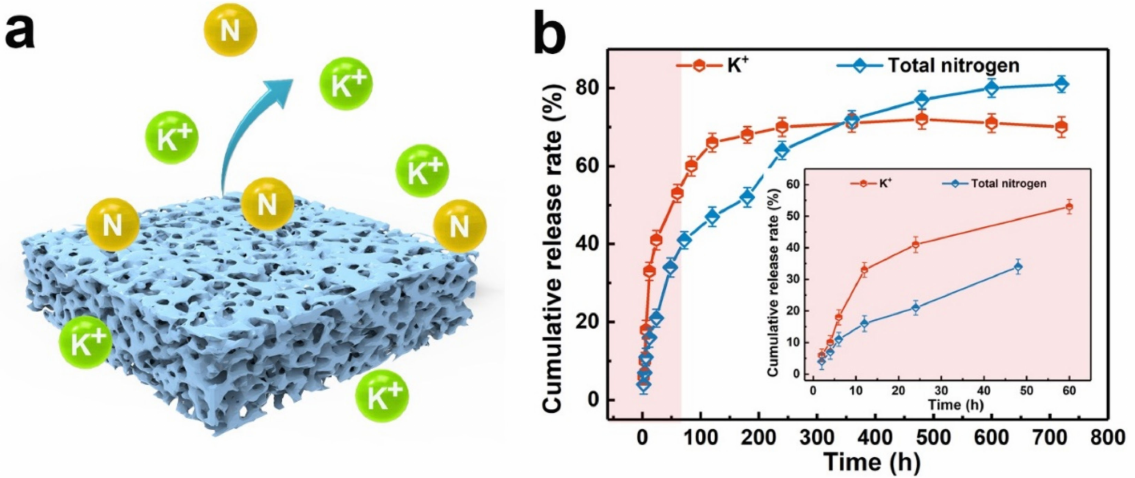
Figure 8. Biofertilizer synthesized from collagen-leather waste cross-linked with acrylic acid (AA) and maleic anhydride (MA), 15% leather waste hydrolysate: ( a ) porous structure; ( b ) N and K release in water. Reprinted with permission from ref. [33]. 2022,